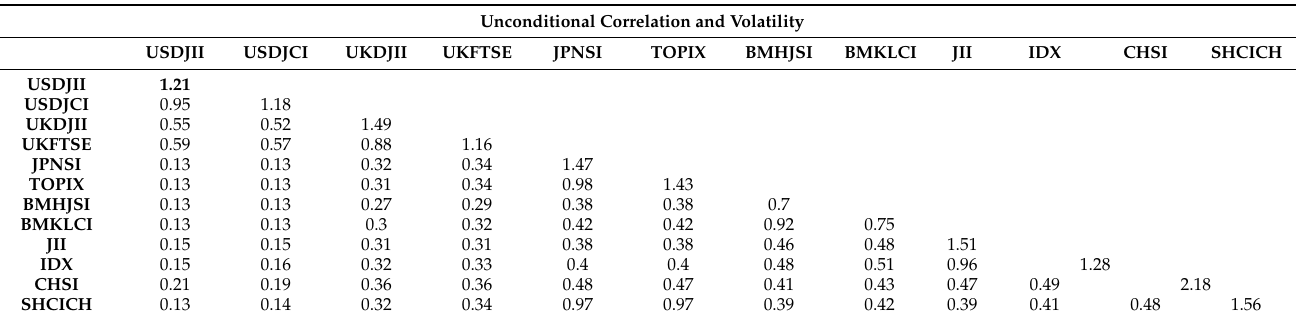
Table 5. Dynamic volatility and correlation analysis.